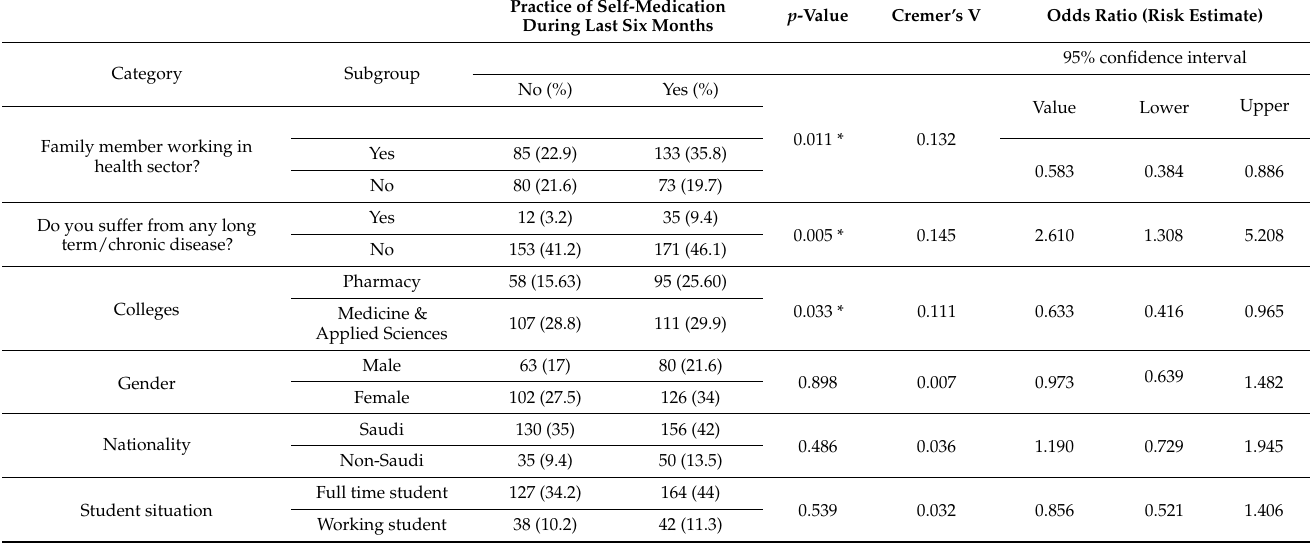
Table 4. Factors influencing self-medication